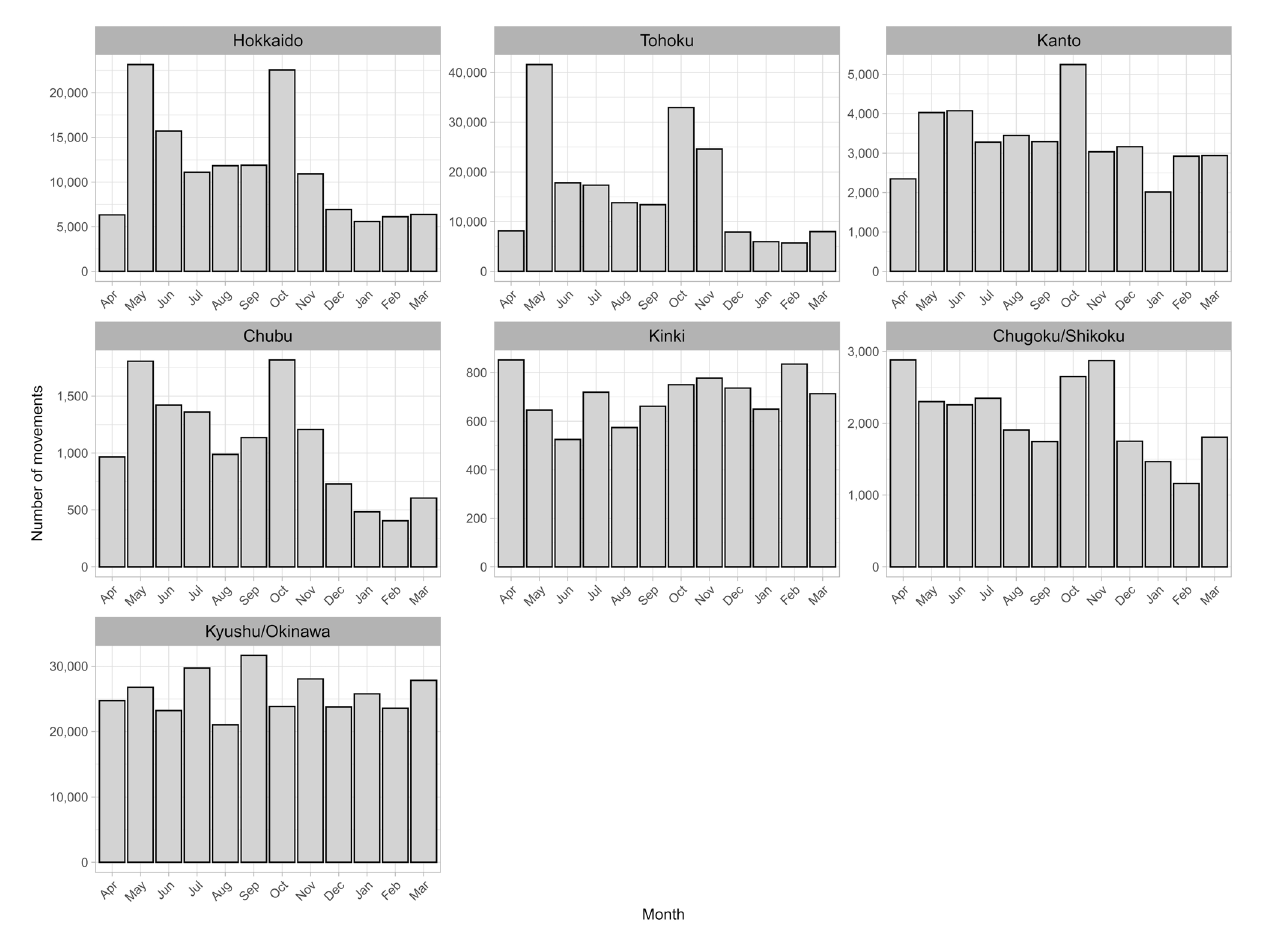
FIGURE5 Number of intra-regional movements of beef cows by region and by month in Japan from FY2012 to FY2017 by